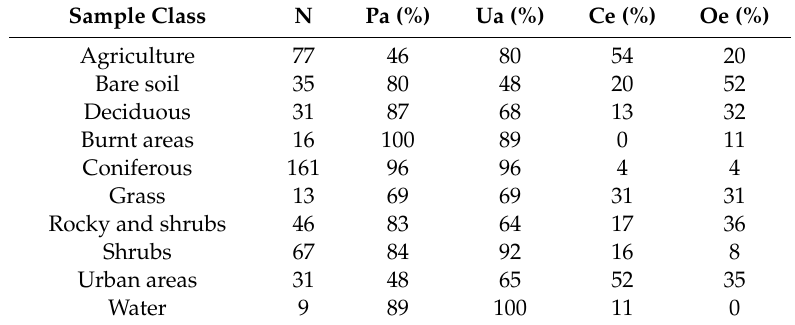
Table 2. Achieved results after confusion matrix for classification accuracy from Sentinel-2 images.